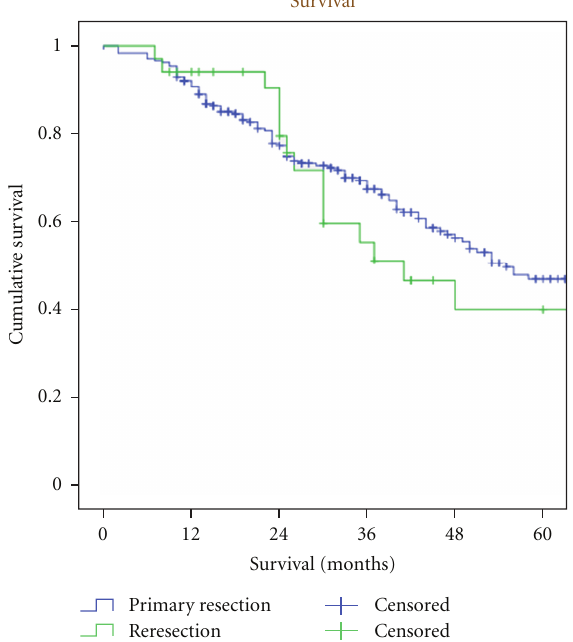
Figure 1: Kaplan-Meier estimate on survival following primary liver resection for colorectal liver metastases and reresection of the liver